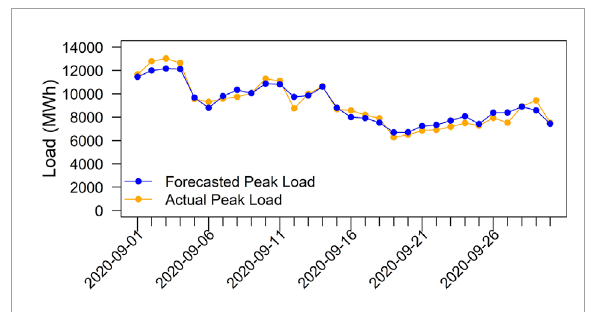
FIGURE 7 Forecast and actual daily peak load of September